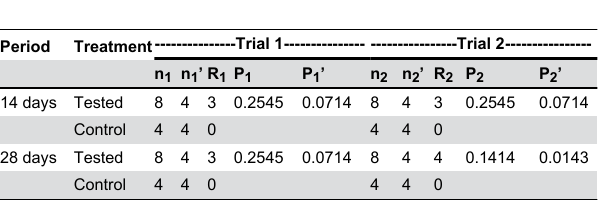
Table 2. Main phenotypic traits of strains XSBZ03 and XSBZ14 compared with V. alginolyticus